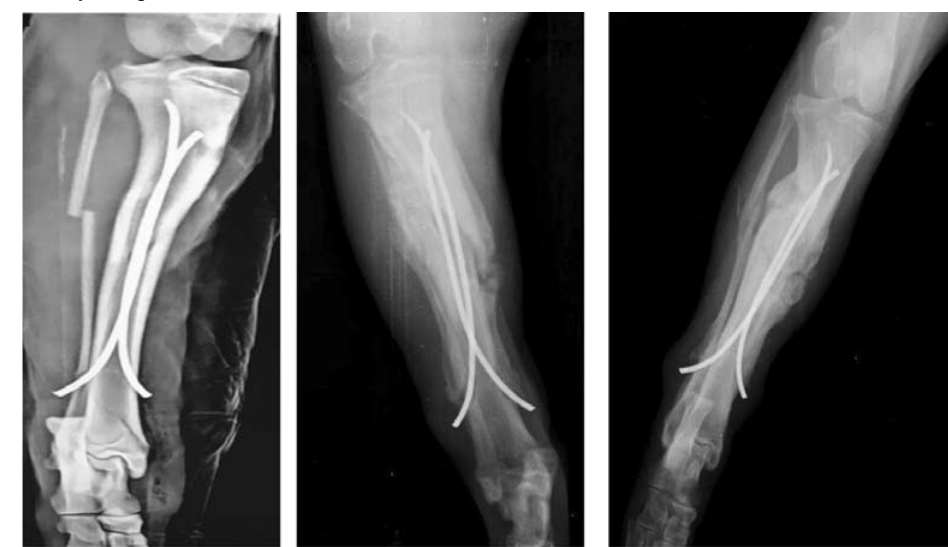
Fig. 4. Postoperative radiographs of tibia in dog treated with ESIN by using TENs on 15 th , 30 th and 60 th post-operative day respectively table 4. Mean ± S.E. of weight bearing scores observed during standing and walking at different time intervals of examination Mean ± s.e. 0 th day During standing 0.00±0.00 During walking table 5. Mean ± S.E of bone formation scores (BFS) and bone union scores (BUS) observed at different time intervals of examination time interval 0 th day 15 th day 30 th day